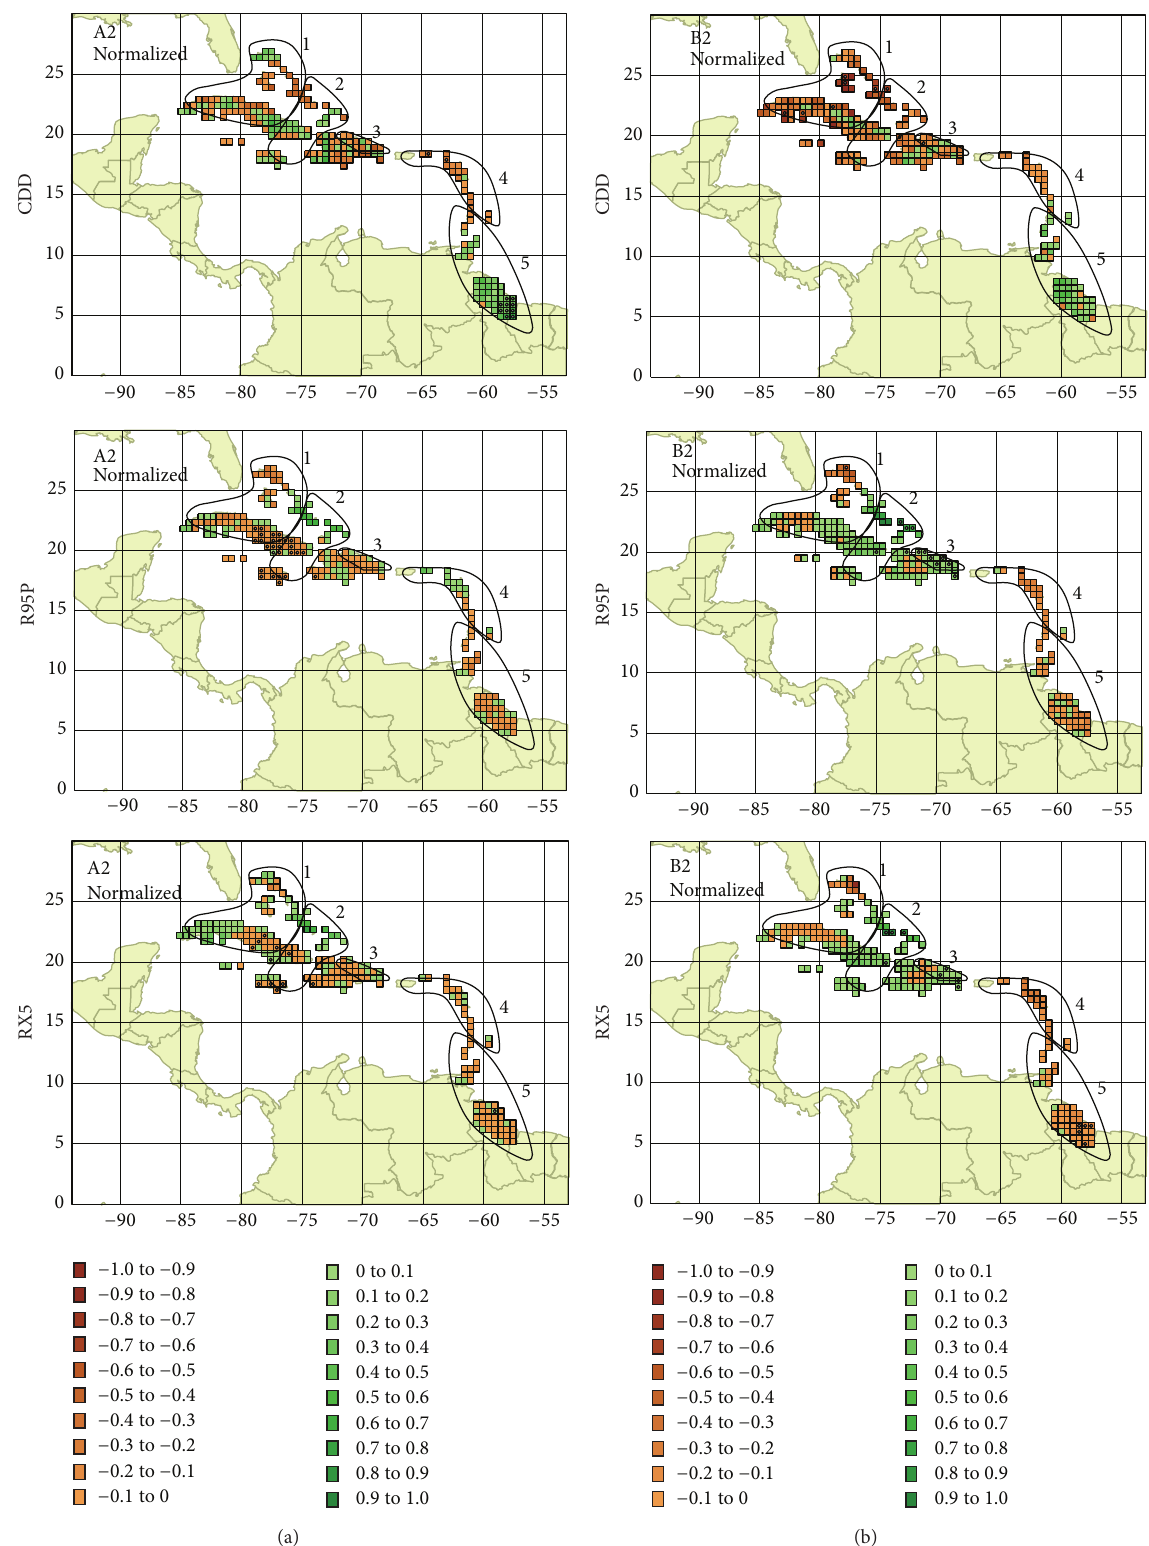
Figure 6: Projected normalized changes in trends for CDD, R95P, and RX5 for 2071–2099 relative to 1961–1989 for the A2 (left panels) and B2 (right panels) IPCC SRES Scenarios. Brown colour indicates negative and green colour indicates positive trends. Statistically significant trends are indicated with white